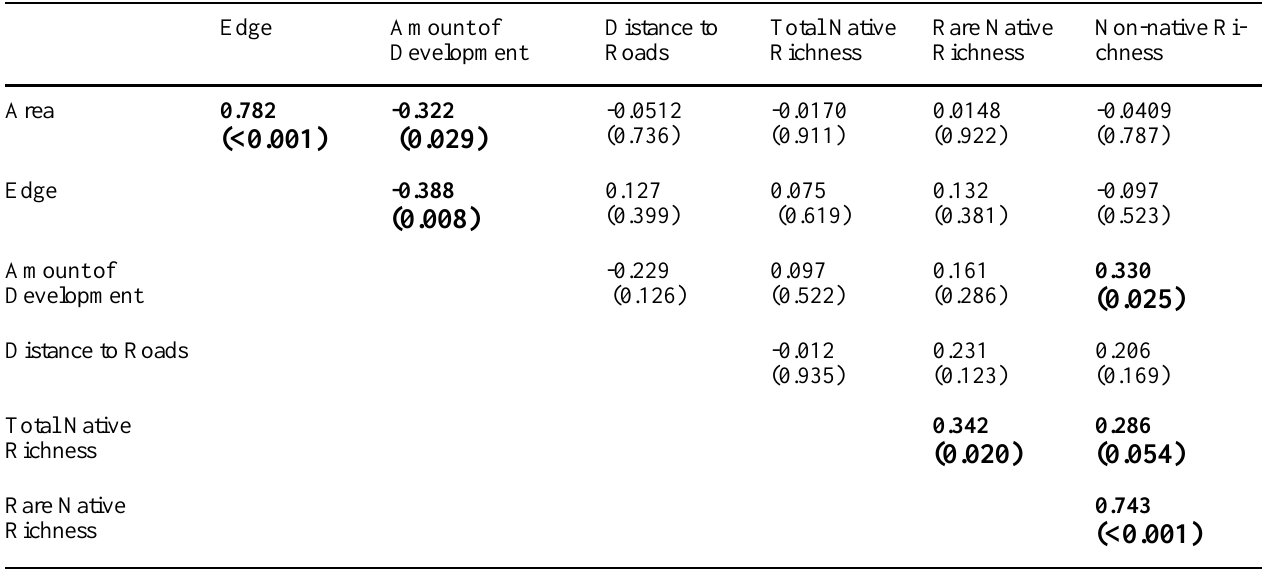
Table 2. Relationships among continuous habitat variables, and species richness estimated at habitat patches in the Lower Florida Keys. The upper number is the Correlation coefficient and the lower number (shown in parentheses) is the significance probability. The bolded numbers indicate a significant ( p < 0.05) result. Edge Amount of Distance to Total Native Rare Native Non-native Ri Development Roads Richness Richness chness Area 0.782 (<0.001) Edge Amount of Development Distance to